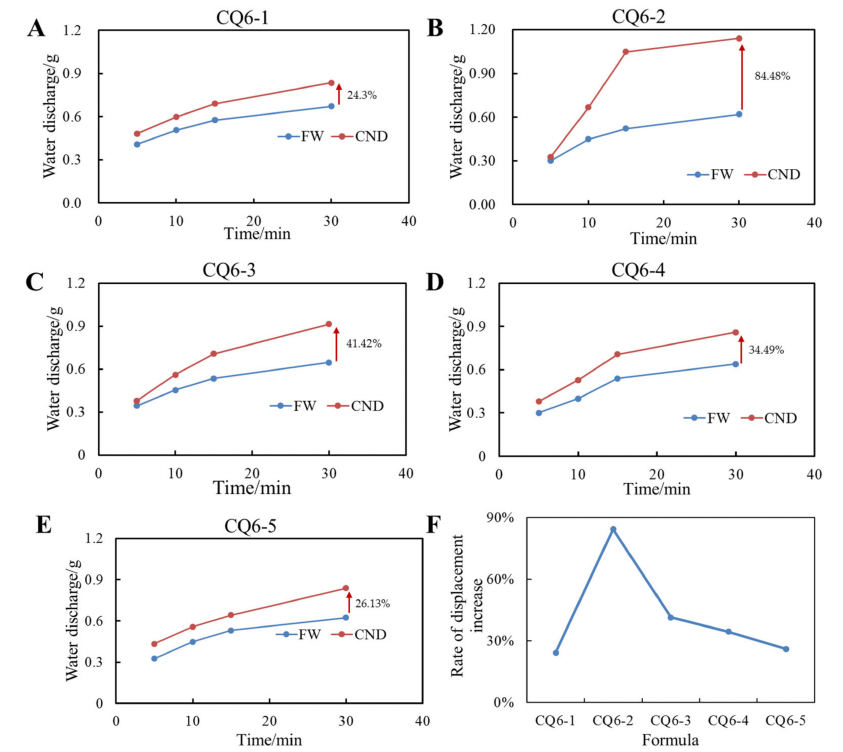
Figure 14. The increasing value of water displacement for different nanoemulsions ( A ) is the water displacement curve of CQ6-1, ( B ) is the water displacement curve of CQ6-2, ( C ) is the water displace- ment curve of CQ6-3, ( D ) is the water displacement curve of CQ6-4, ( E ) is the water displacement curve of CQ6-5, ( F ) is the water displacement change